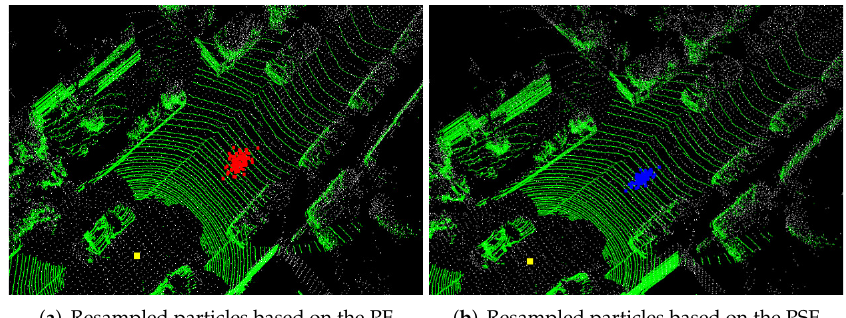
Figure 4. Comparison with different particle filter algorithm for resampled